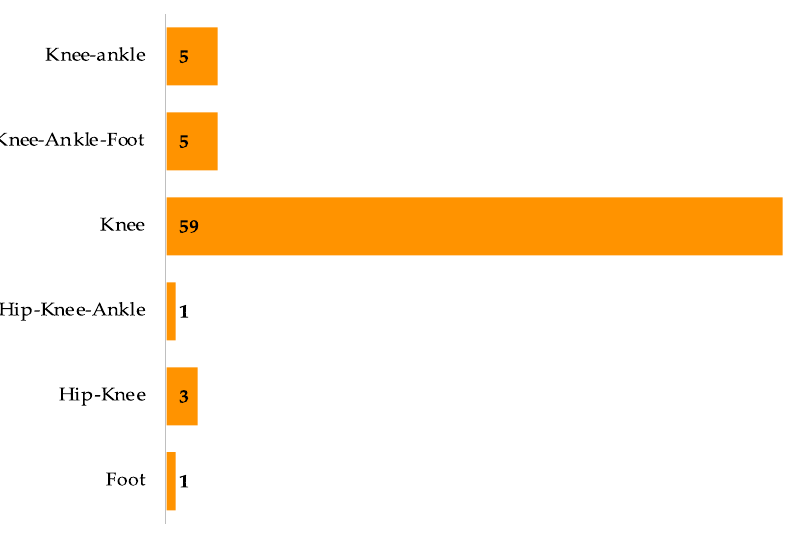
Figure 6. Documents by lower limb joint.